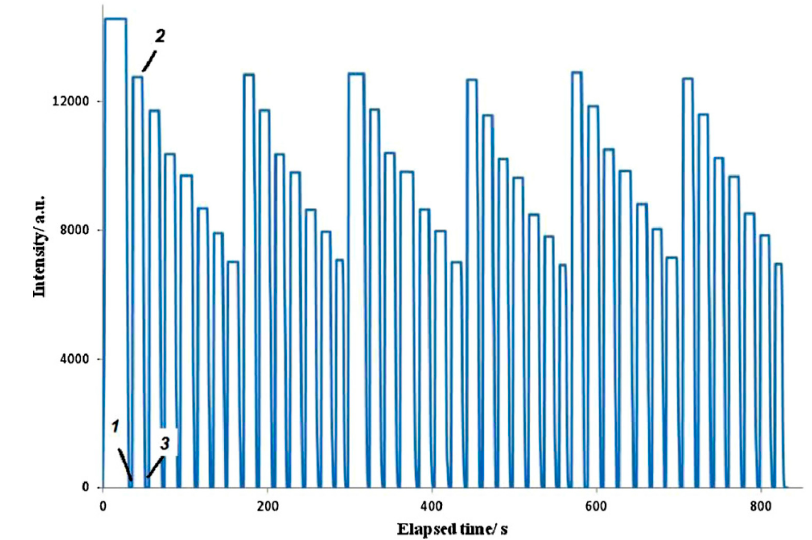
Figure 5. Steady-state fluorescence measurements over time (excitation 380 nm and emission 500 nm) of the dry optical fiber with six layers, followed by three cycles of Hg(II) aqueous solutions with in the following concentrations: 0, 0.01, 0.05, 0.1, 0.799, 1.99 and 2.69 µM. (1) The fiber was immersed in water, (2) removed from water, and (3) immersed in Hg(II) 0.01 µM. Reprinted with permission from Ref. [36].